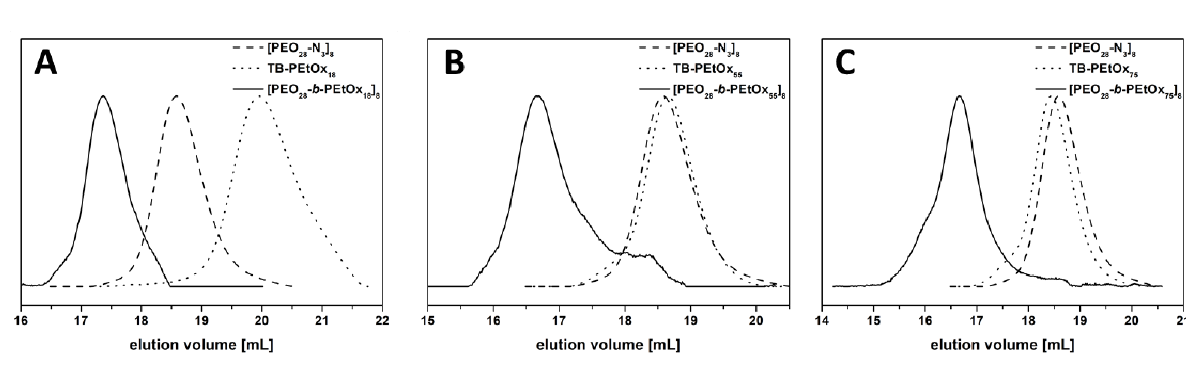
(dotted line), x - b -PEtOx ] 28 x 8 - b -PEtOx ] 28 75 8